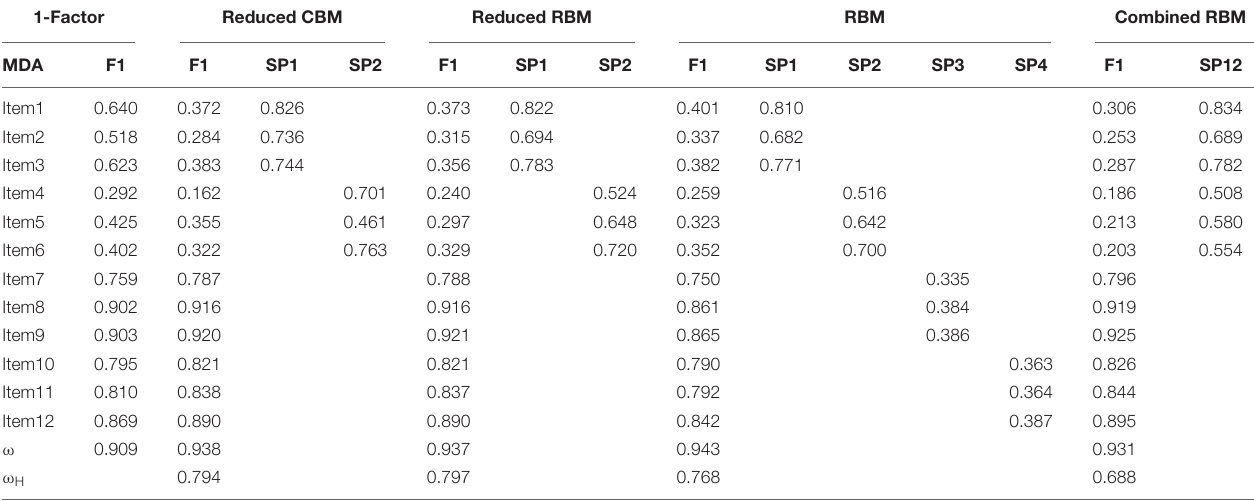
TABLE 5 | Standardized factor loadings from the confirmatory factor